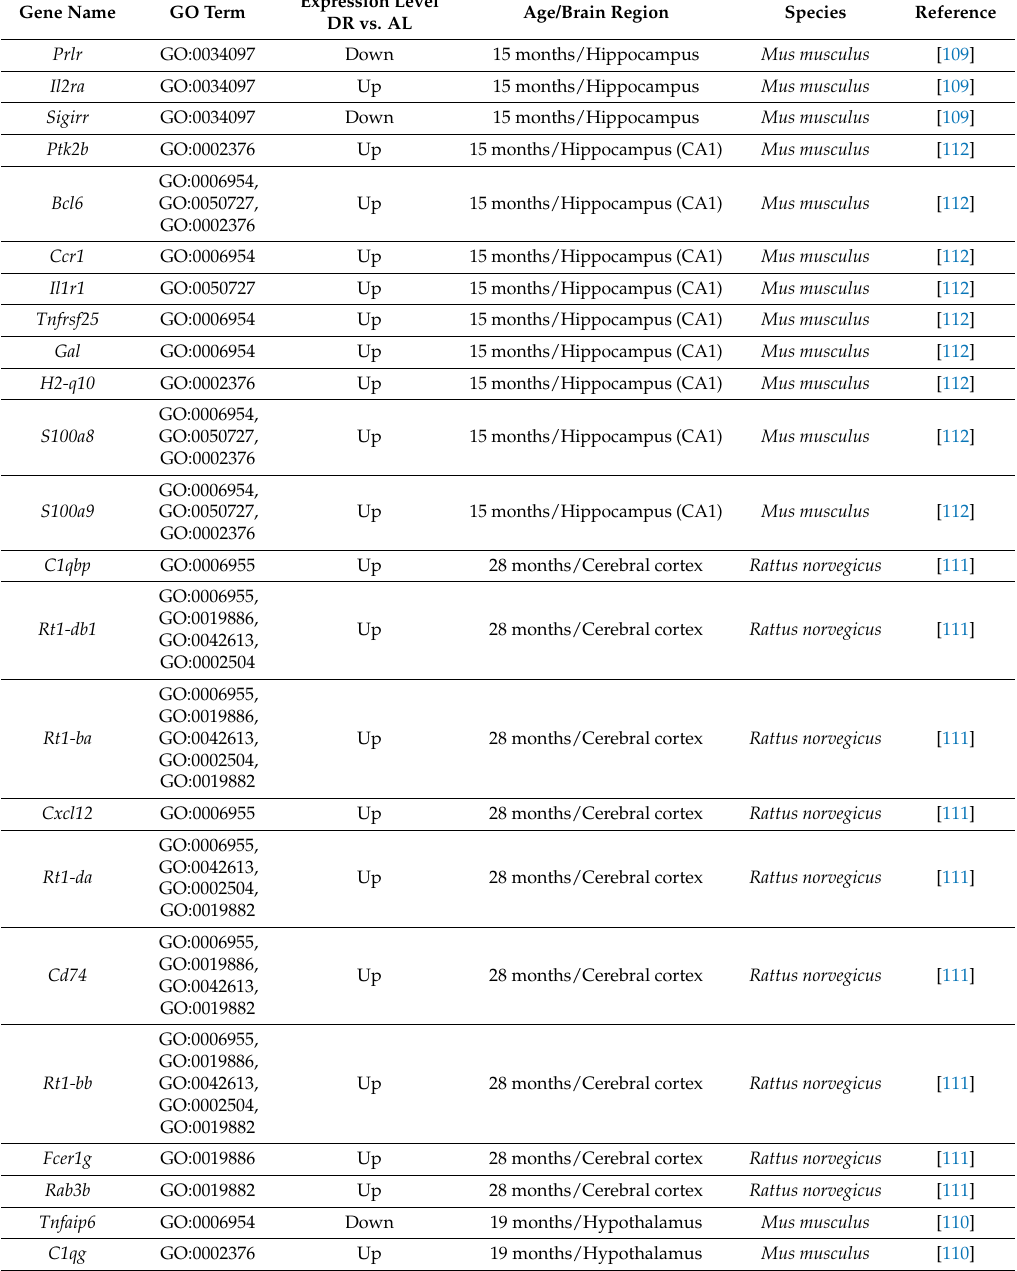
Table 3. List of DEGs associated with inflammation/immune response in dietary restriction during